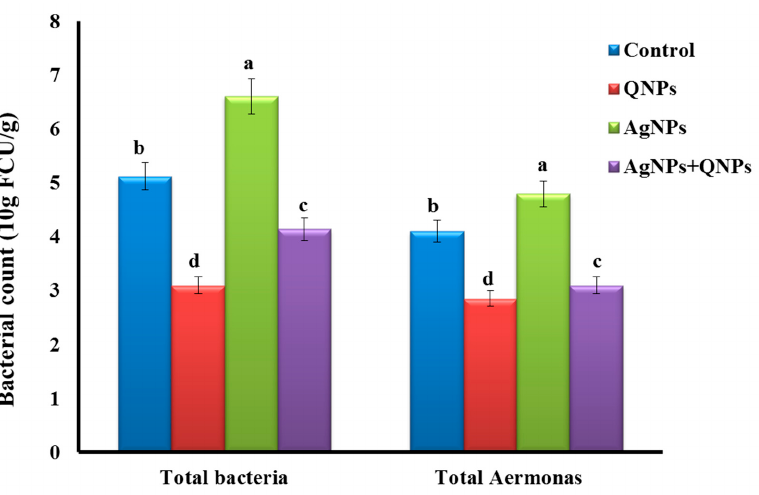
Figure 4. Total bacteria and Aeromonas counts in the fish intestine. Control group (basal diet), QNPs group (QNPs at a concentration of 400 mg kg − 1 diet), AgNP group (AgNPs at a level of 1.98 mg L − 1 ), and AgNP + QNP group (QNPs and AgNPs). Values are presented as mean ± SEM. Values with a common superscript letter (a, b, c, d) significantly differ ( p <